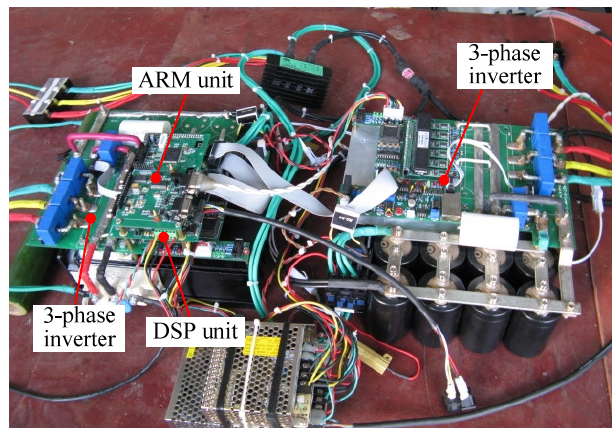
Figure 10. Photograph of the CS-PMSM